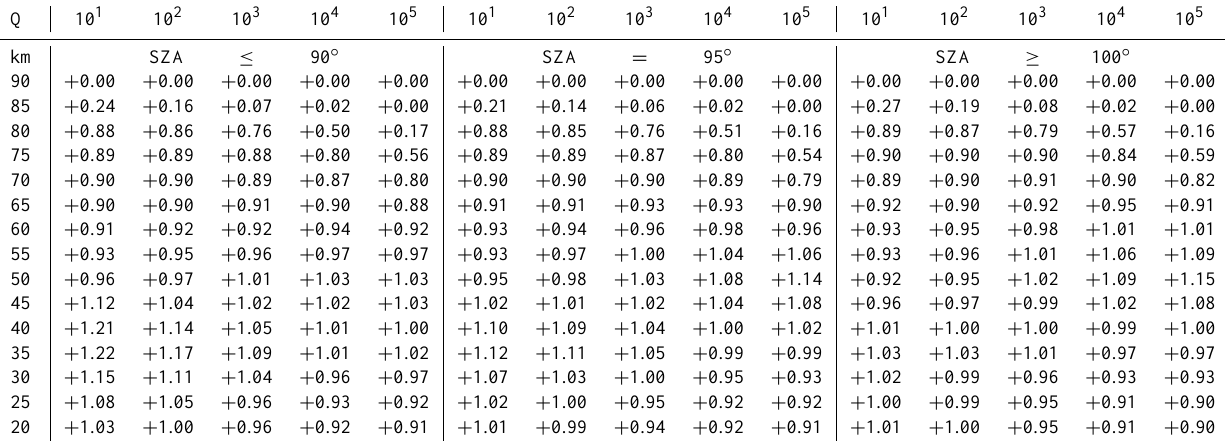
Table A17. P OH /Q for October NH.